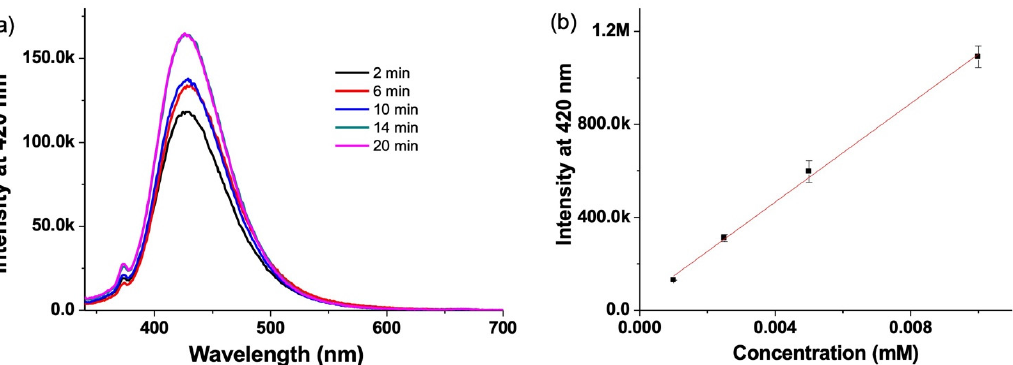
Figure 5. ( a ) Fluorescence spectra of HTA obtained by the reaction of CuSO 4 (1 mM) and H 2 O 2 (10 mM) with Na 2 TH (100 mM), 2 min (black), 6 min (red), 10 min (blue), 14 min (green) and 20 min (pink)) and ( b ) calibration curve obtained by plotting the fluorescence intensity at 420 nm for different concentrations of HTA.